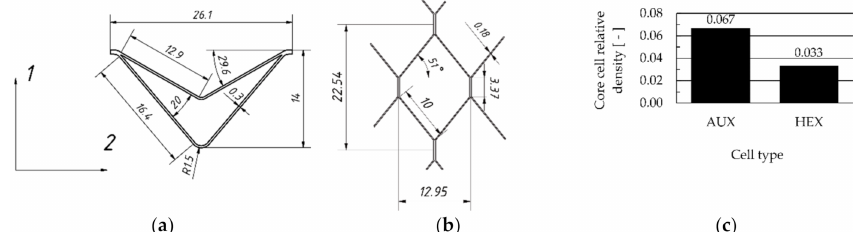
Figure 2. Tested core cells: ( a ) double arrow-shaped auxetic and ( b ) hexagonal and ( c ) relative density of cells.